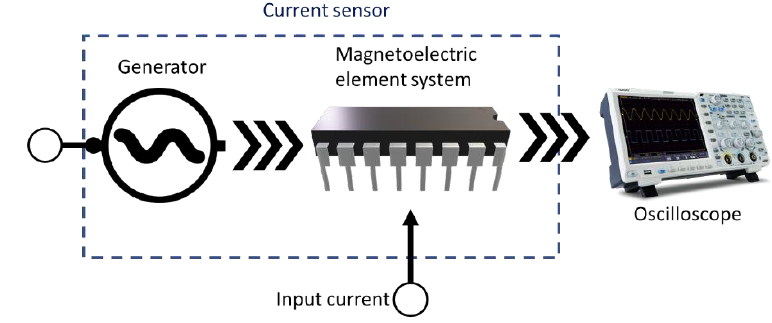
Figure 7. The operating principle of the ME current sensor.